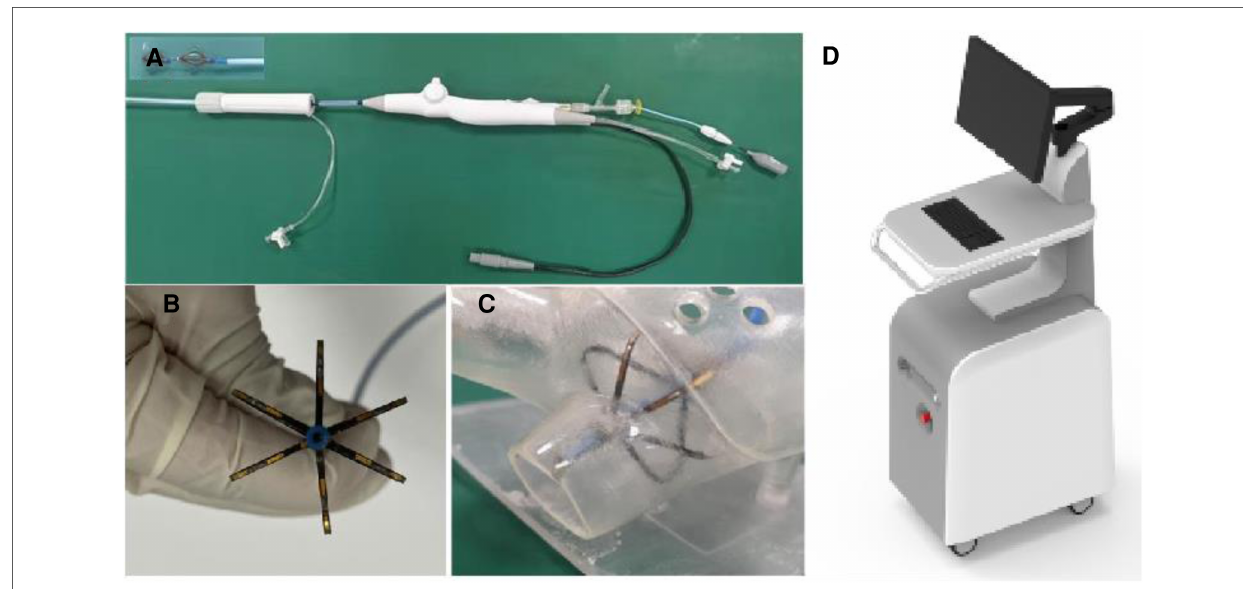
FIGURE 1 PFA system, ( A ) the ablation catheter, ( B ) the electrode part at the end of the ablation catheter, ( C ) the schematic diagram of the catheter placed in the left atrium model, and ( D ) the PFA pulse